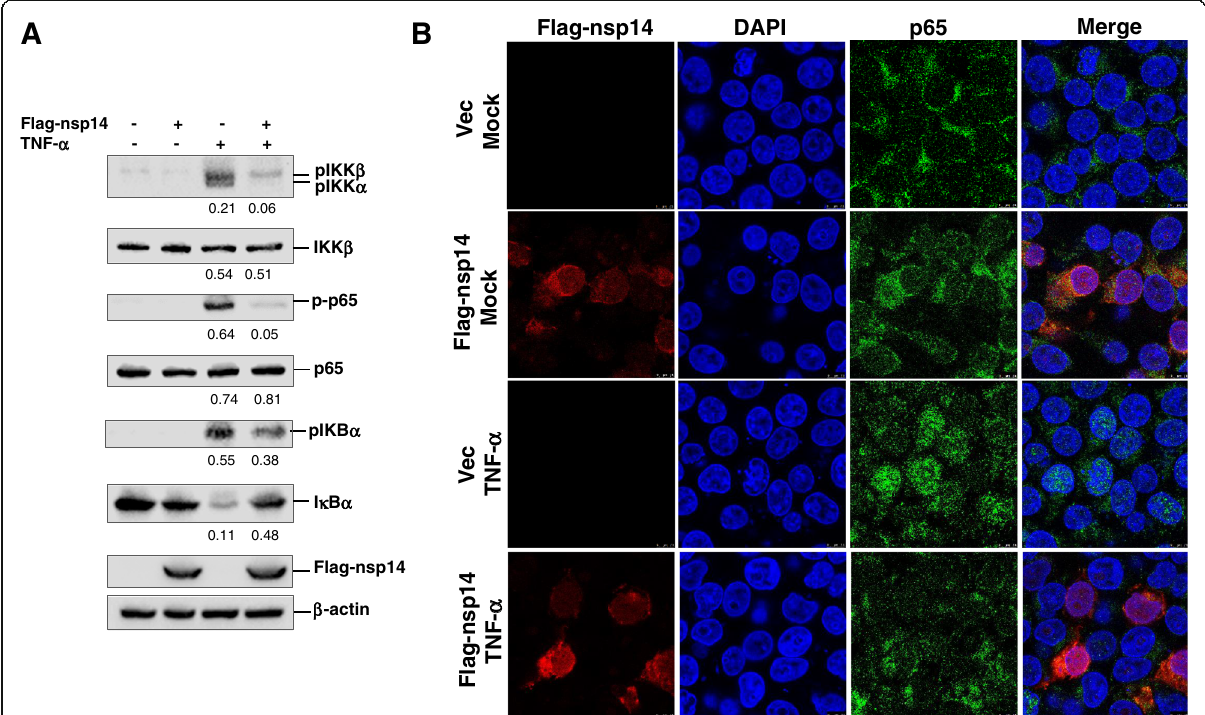
Fig. 6 PEDV nsp14 inhibites IKK α / β and p65 phosphorylation and nuclear translocation of NF- κ B. A HEK293T cells were transfected with 1 μ g vector plasmids or Flag-nsp14 expression plasmids. At 24 hpt, cells were treated with TNF- α (30 ng/mL) or mock-treated for 30 min. Cell lysates were then prepared, and the target proteins were detected by Western blotting. B Double immunostained of transfected HEK293T cells treated in the same way as with anti-Flag (red) and anti-p65 (green)